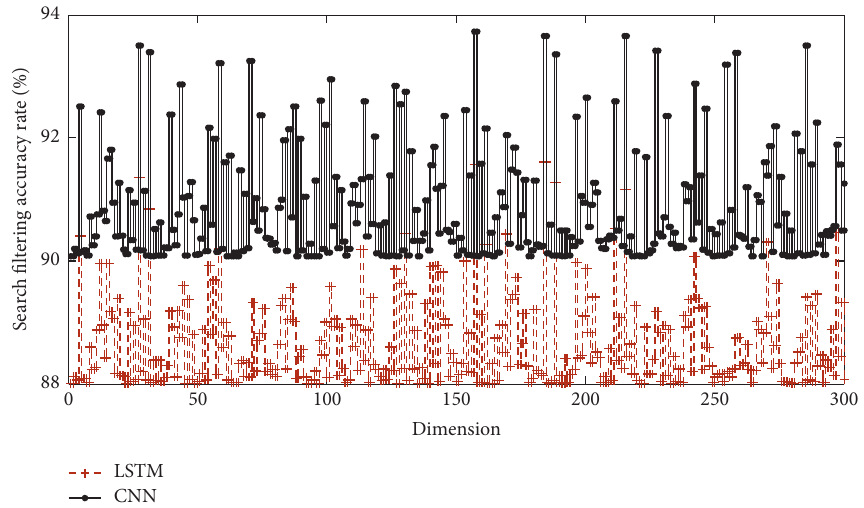
Figure 9: The accuracy of search filtering at the appraisal level.